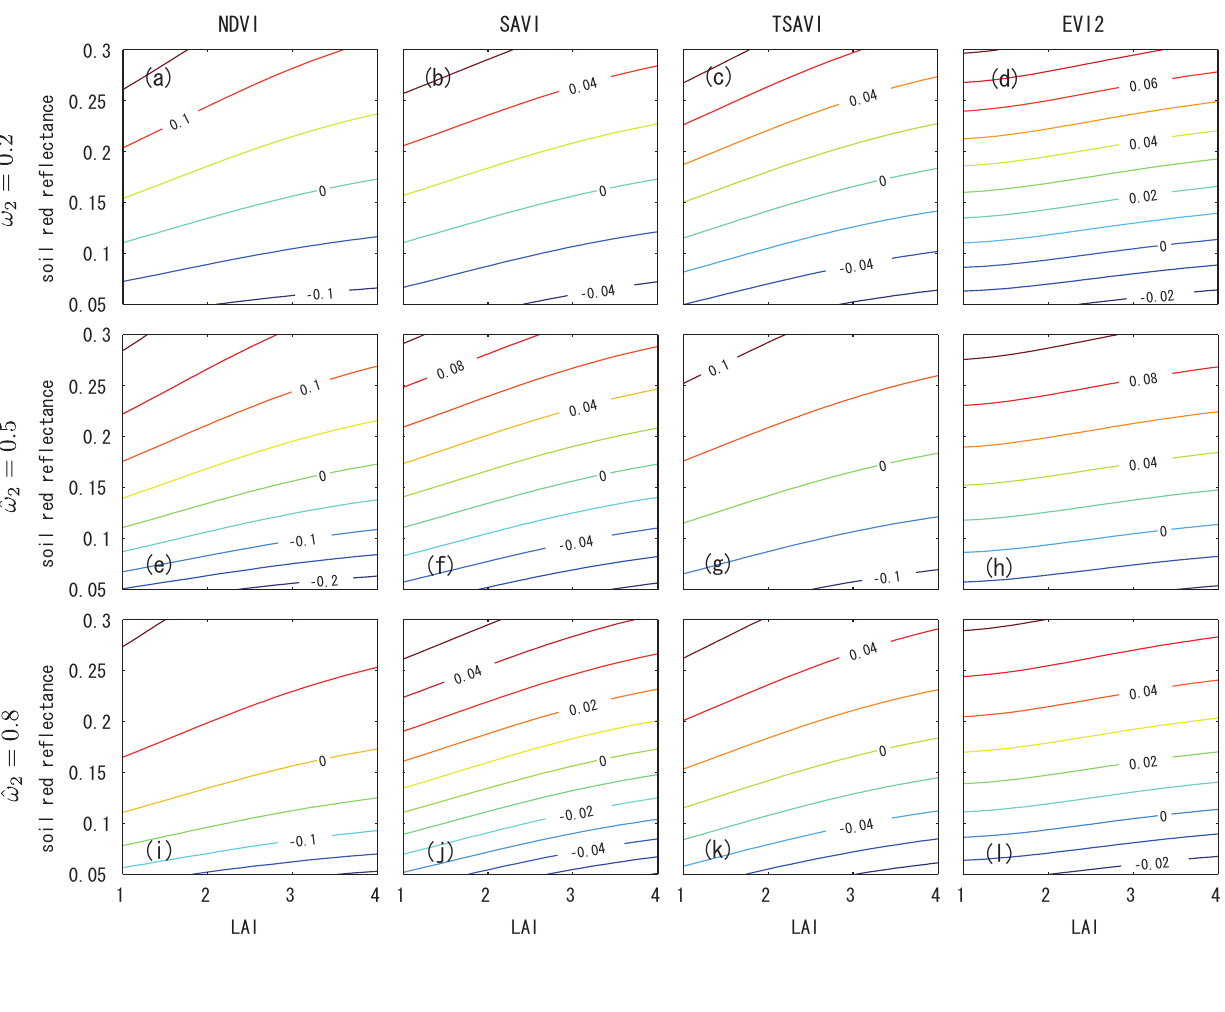
− ^ ω ) for the cases of (a) NDVI, (b) SAVI, (c) TSAVI, and Figure 7 . Contour plots of (^ ω 3 2 (d) EVI2 as a function of vegetation and non-vegetation endmember spectra at fixed values of ^ ω (0.2, 0.5 and 0.8.) Variations of vegetation and non-vegetation endmember spectra are 2 represented by LAI (in x-axis) and soil reflectance of red band (in y-axis),